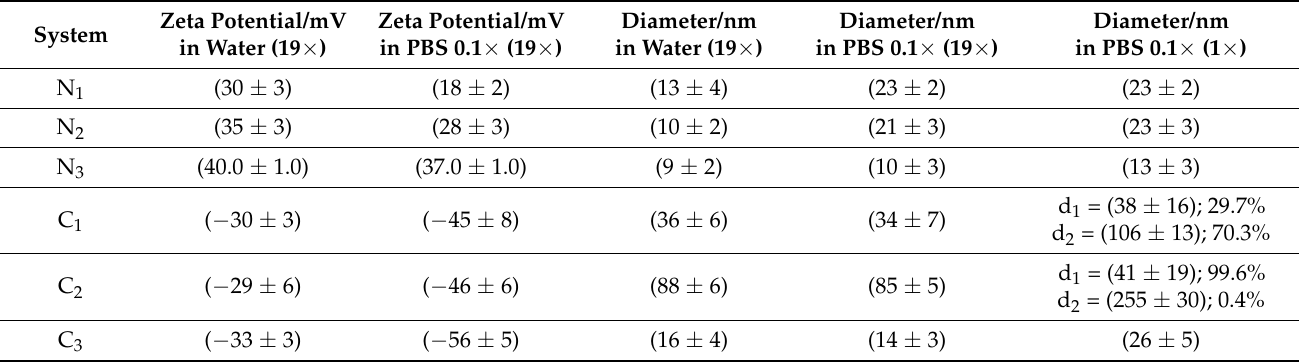
Table 2. Zeta potential and dynamic light scattering (DLS) size distribution by number of Au@16-Ph-16 precursors and Au@16-Ph-16/DNA–5-Fu-compacted nanosystems at different concentrations in water and phosphate-buffered saline (PBS) 0.1 × (ionic strength = 1.63 mM and pH = 7.4). Abbreviations: 19 × and 1 × correspond to 19 × and 1 × preparations for Ci and Ni formulations,